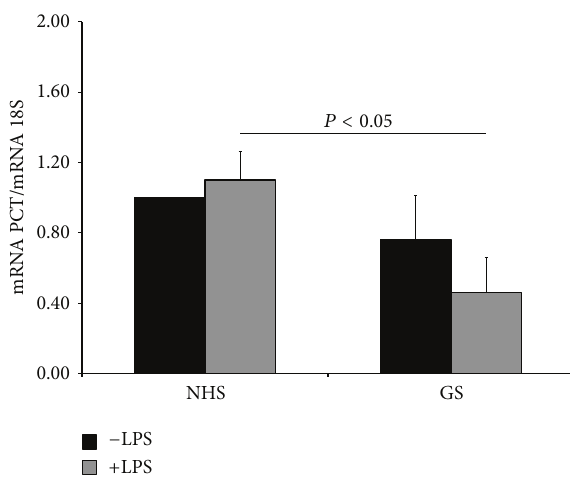
Figure 4: The expression of PCT is negatively regulated in human macrophages conditioned for 24 hours with gravid serum (GS), reaching significance after stimulation with 100ng/mL of LPS for 3 hours. mRNA expression levels of these proteins were measured by qPCR and normalized to those of the human housekeeping gene 18S. Results were expressed as AUs, in which 1AU represents the value obtained with macrophages cultured in NHS used as a positive control. Bars represent the mean ± S.E.M. of at least 3 independent experiments. ∗ 𝑃 < 0.05 (Mann-Whitney test).